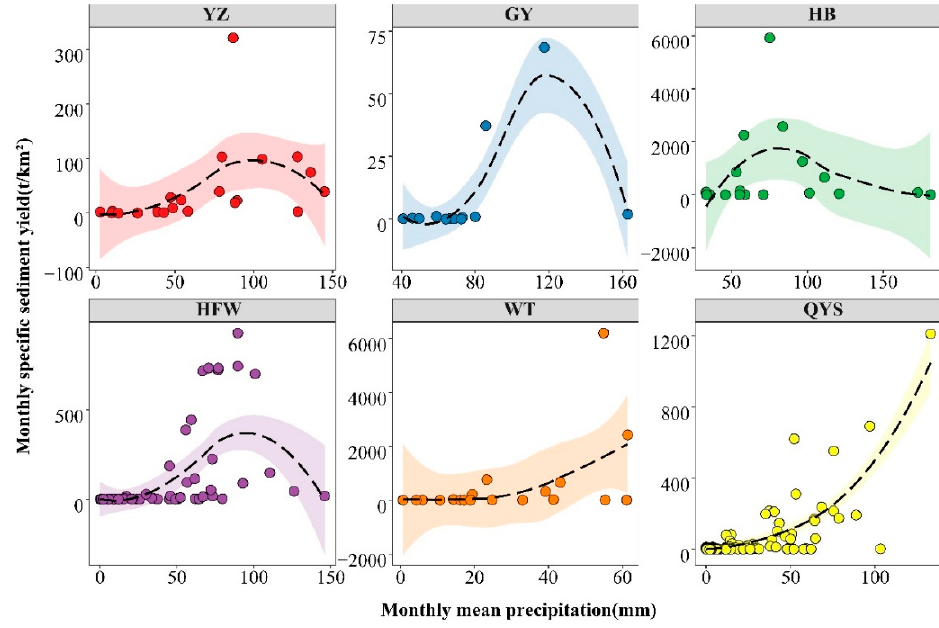
Figure 11. Relationships between monthly specific sediment yield and monthly precipitation.